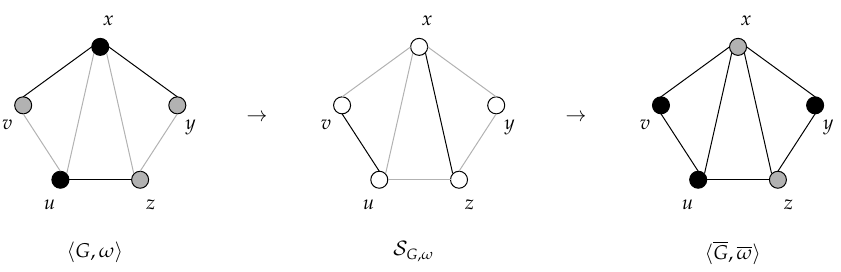
Figure 1. An example of the construction of the structurally balanced support graph S G , ω of a structurally balanced graph G = ( V , E , λ ) in an opinion configuration ω and, then, of the construction of an opinion configuration ω of the unsigned graph G = ( V , E ) such that S G , ω = S edges as well as negative node labels are grey, and positive ones are